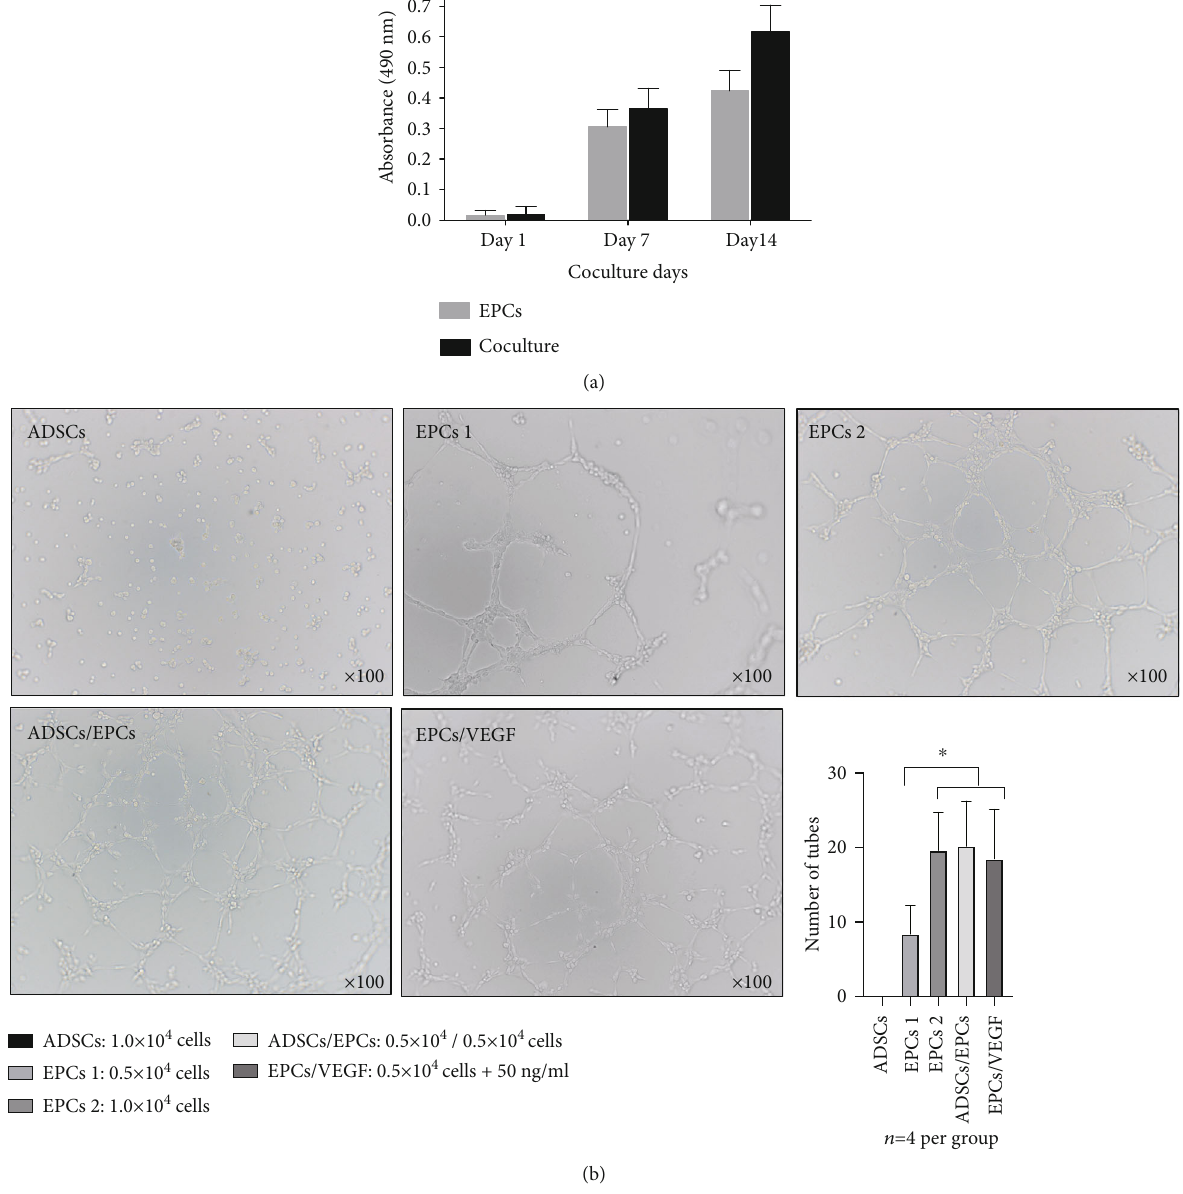
Figure 2: ADSCs enhanced the proliferation and angiogenesis of EPCs in vitro. (a) MTT assay showed that the number of EPCs cocultured with ADSCs was signi fi cantly more than EPCs cultured alone. ∗ p < 0 : 05 . n = 3 per group. (b) More tubes were formed on Matrigel by 0 : 5 × 10 4 / 0 : 5 × 10 4 ADSCs/EPCs, 1 : 0 × 10 4 EPCs or 0 : 5 × 10 4 EPCs+50 ng/ml VEGF compared to 0 : 5 × 10 4 EPCs. ∗ p < 0 : 05 . n = 4 per group. MTT: 3-(4,5-dimethyl-2-thiazolyl)-2,5-diphenyl-2-H-tetrazolium bromide; VEGF: vascular endothelial growth